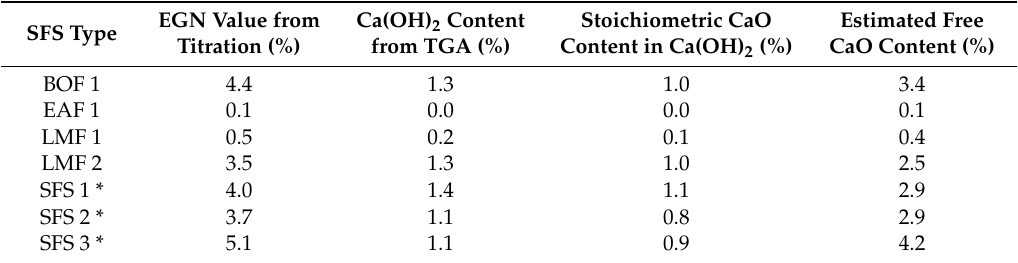
Table 7. Estimated total free CaO contents based on titration and TGA